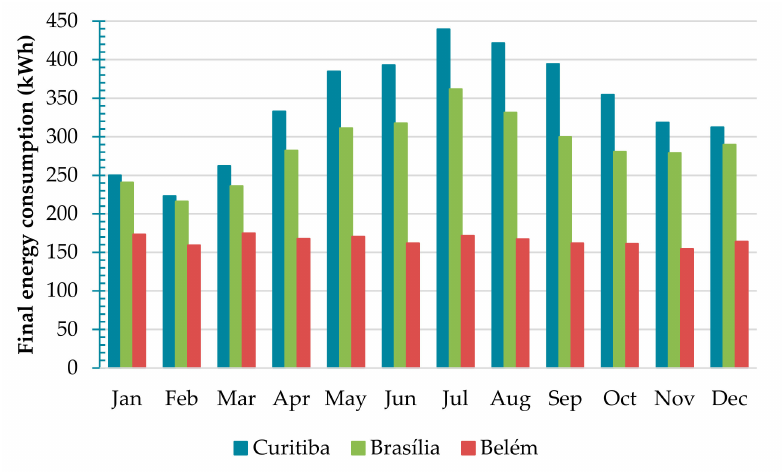
Figure 7. Final electricity consumption using instantaneous gas heater system.